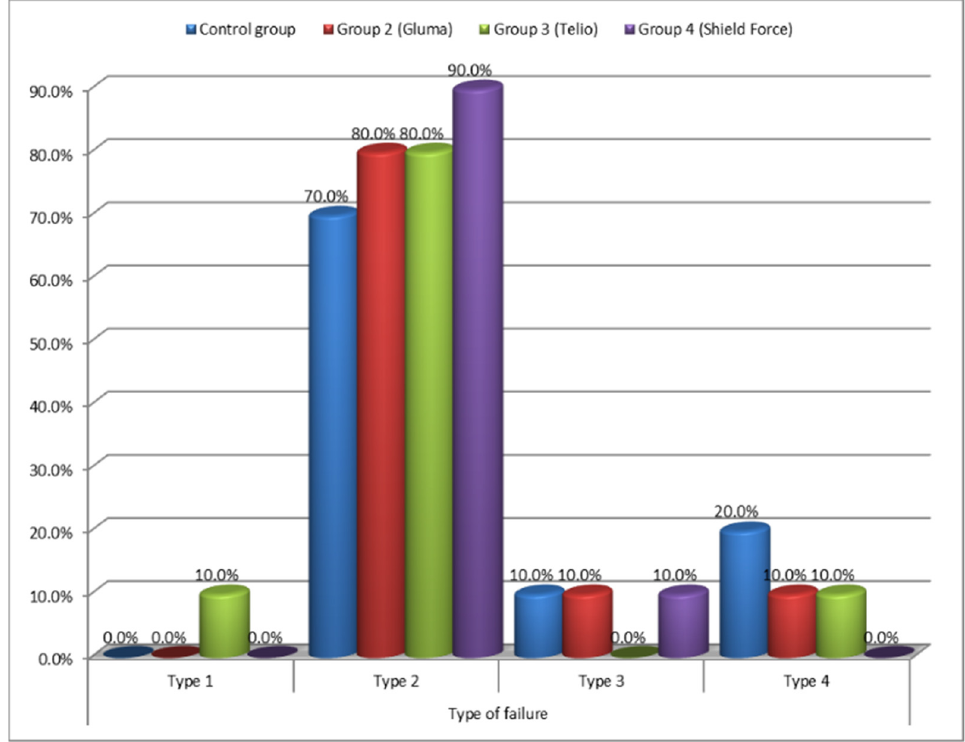
Figure 6. Comparison of the failure-type distribution in the four groups. Group 2: Treated with Gluma dentin desensitizer; Group 3: Treated with Telio CS desensitizer; Group 4: Treated with Shield Force Plus desensitizer.